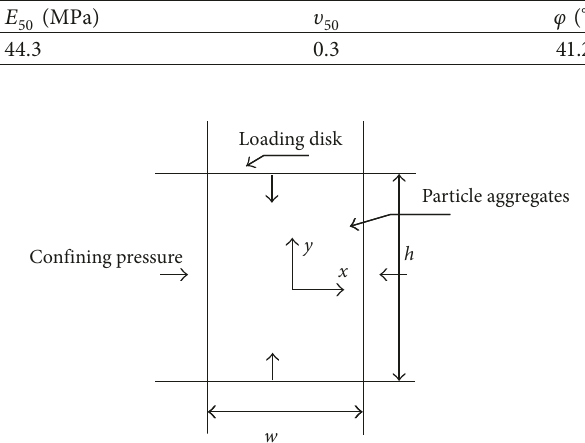
Figure 1: Model for the numerical sample.